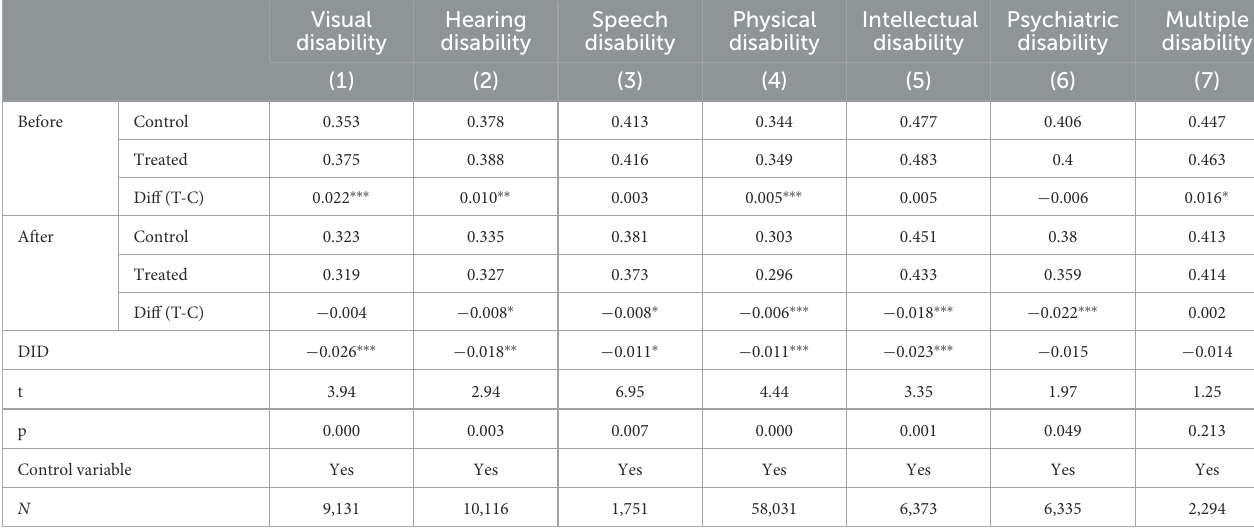
TABLE 9 Effect of employment services on MPI of different disability